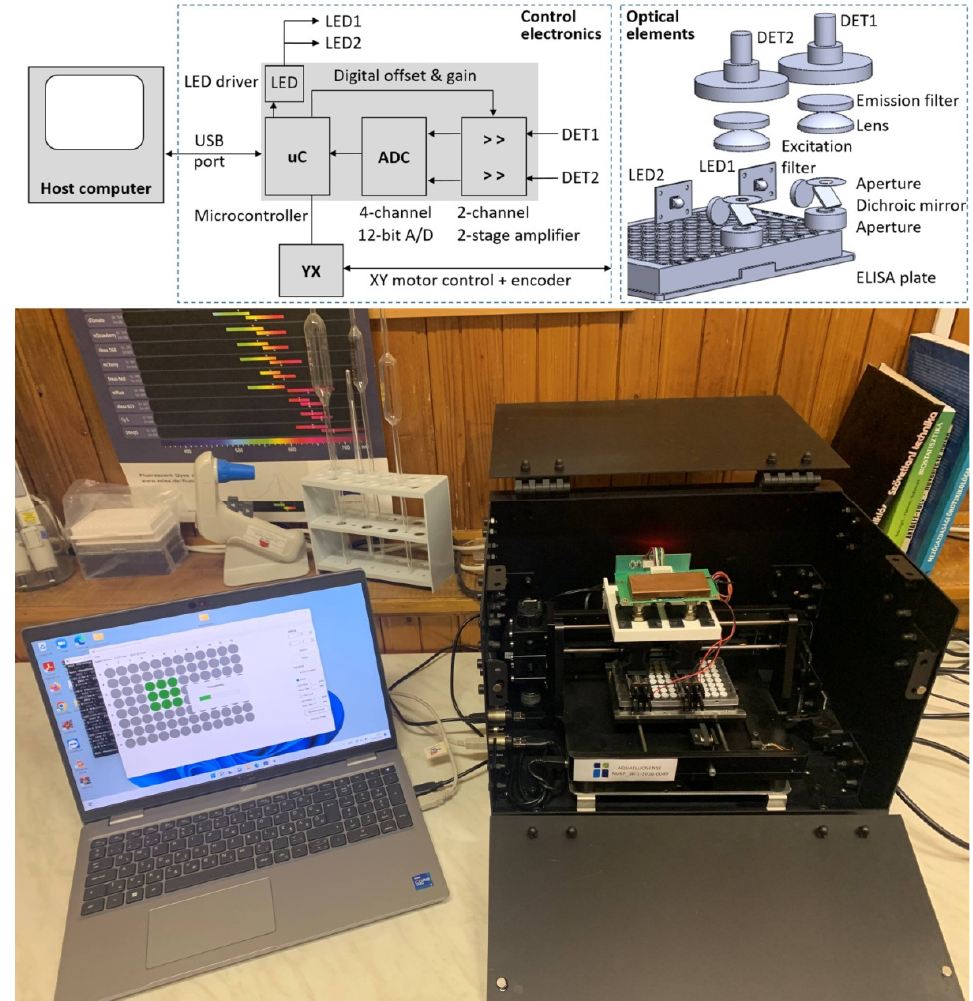
Figure 4. Scheme (top) and photograph (bottom) of the immunofluorescence module prototype of the induced fluorescence instrument developed in Project Aquafluosense to detect environmental pollutants and water quality parameters.